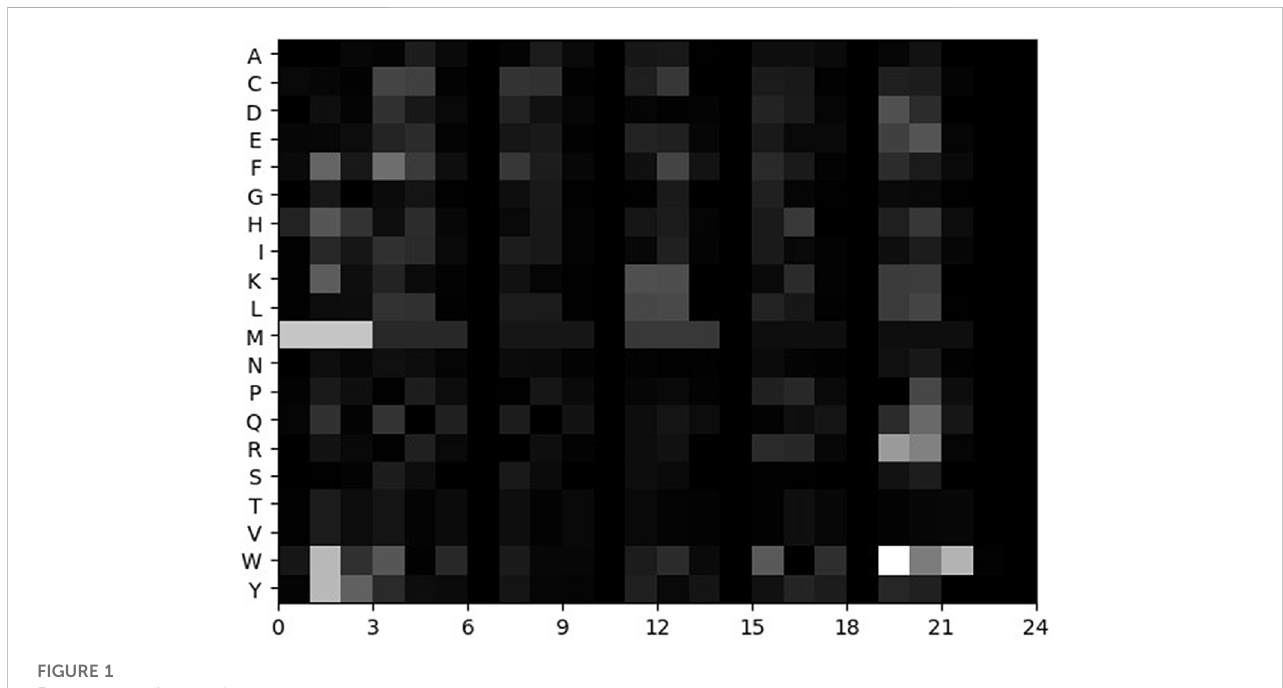
FIGURE 1 Feature map of a